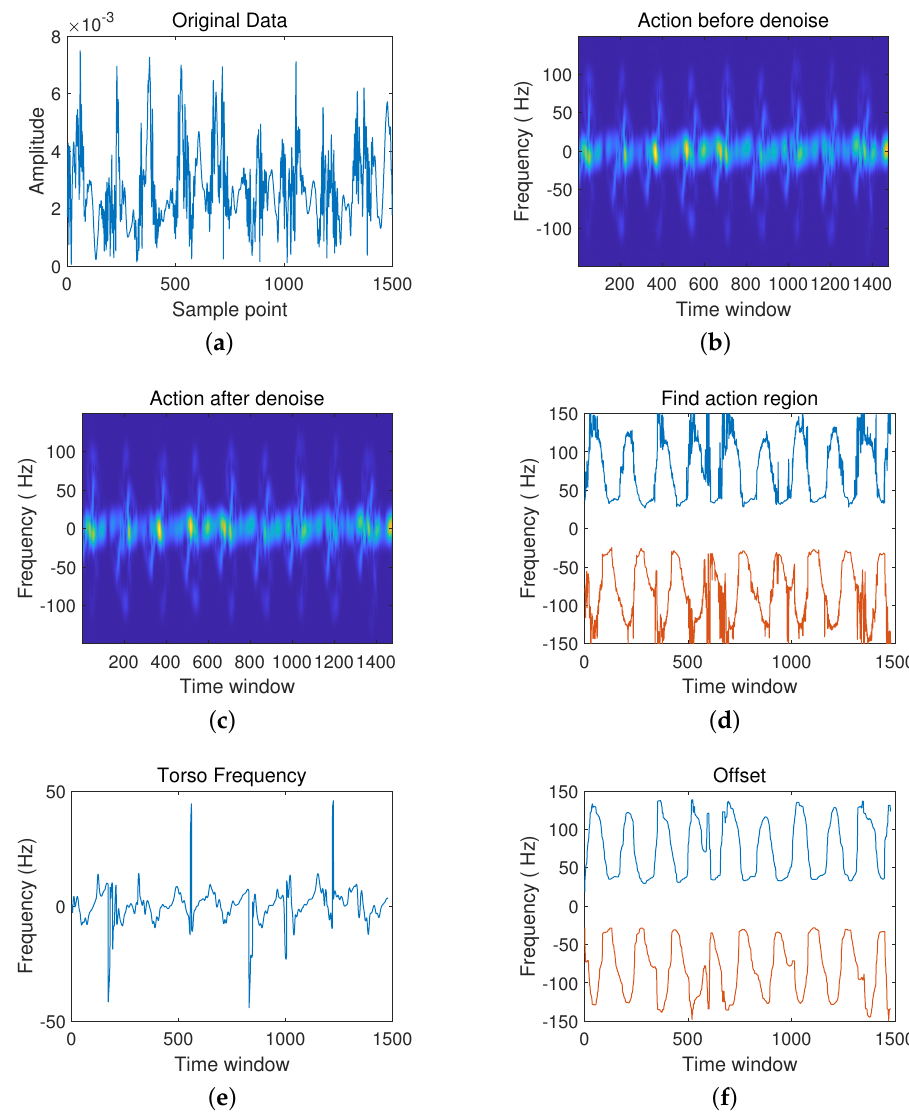
Figure 9. Schematic Diagram in walking in place. ( a ) The original data; ( b ) Frequency spectrum diagram before noise reduction; ( c ) Frequency spectrum diagram after noise reduction; ( d ) Action interval; ( e ) Body frequency; ( f )